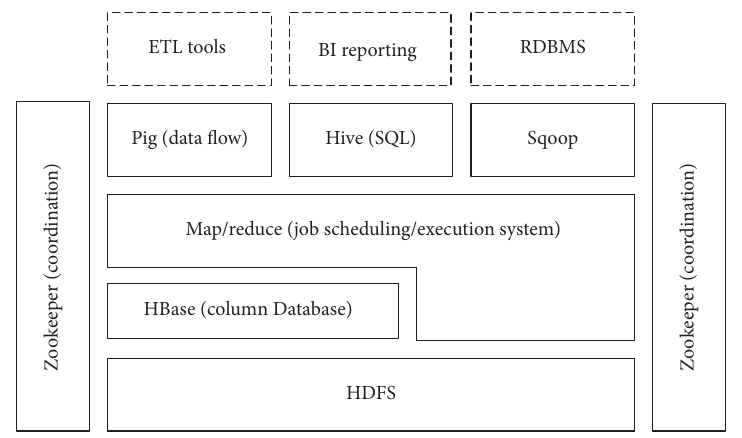
Figure 3: Hadoop ecosystem.